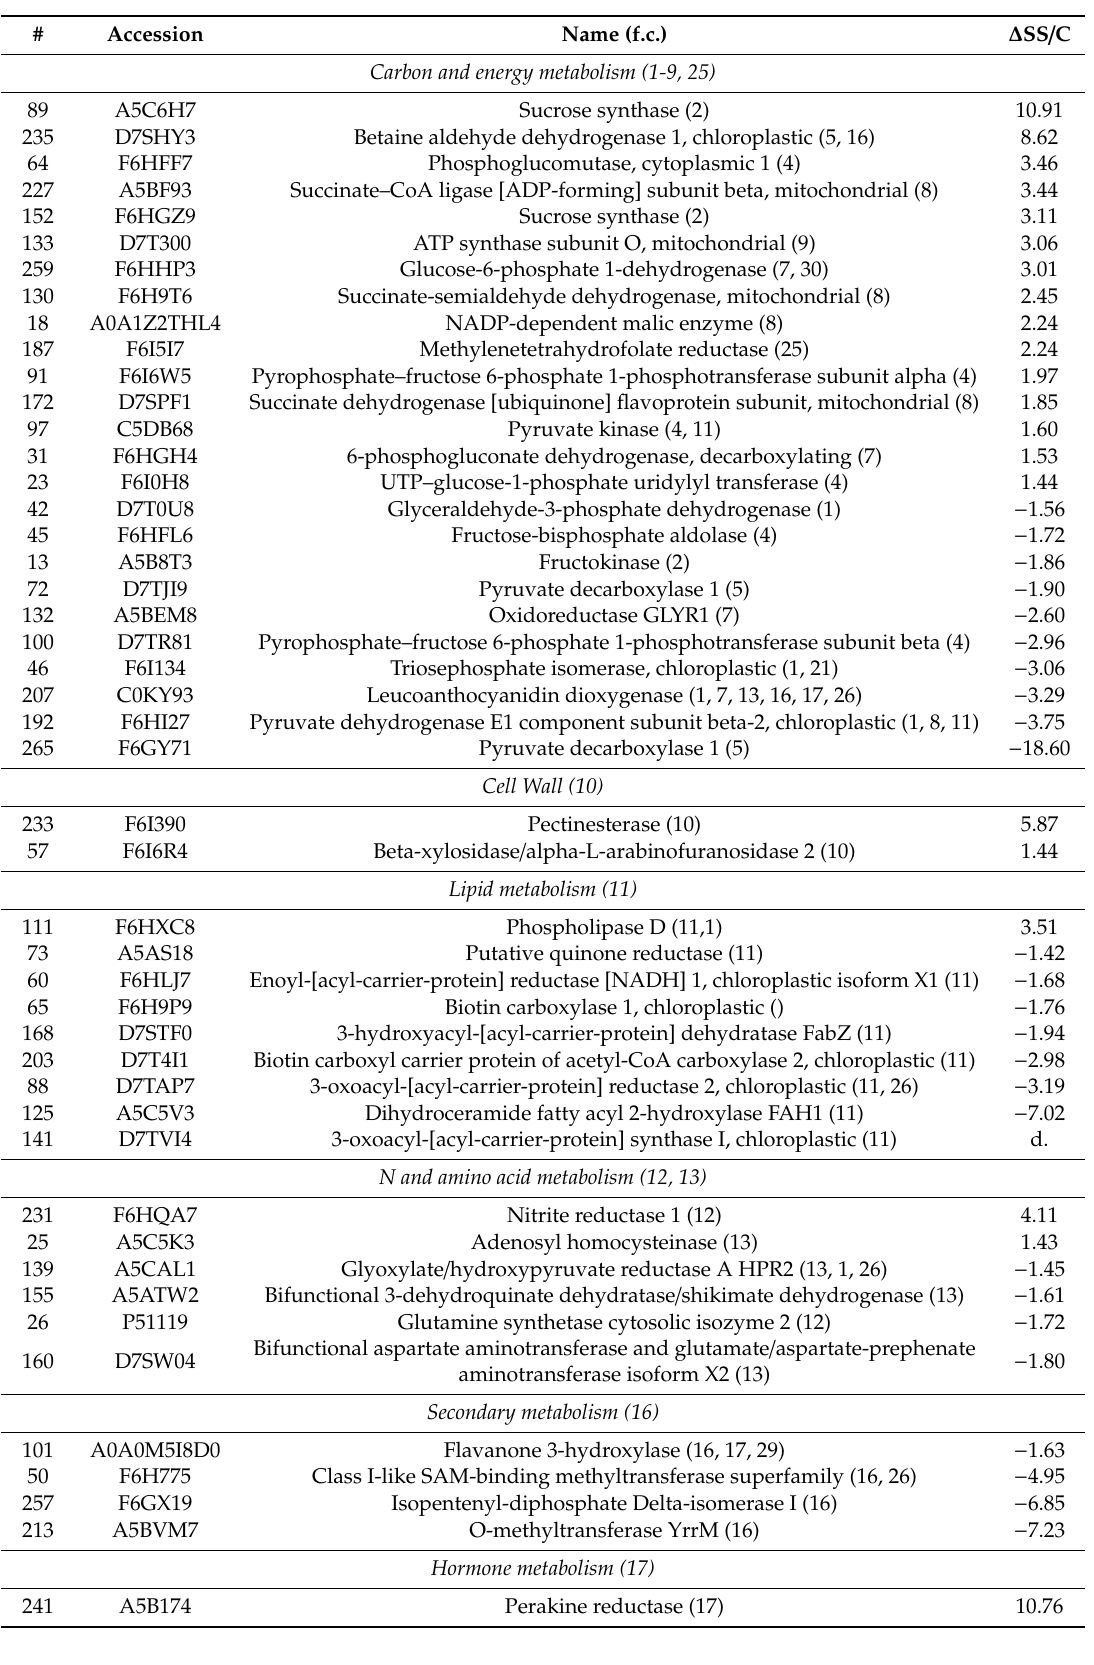
Table 3. Proteins showing significant changes in responses to salt stress in the M4